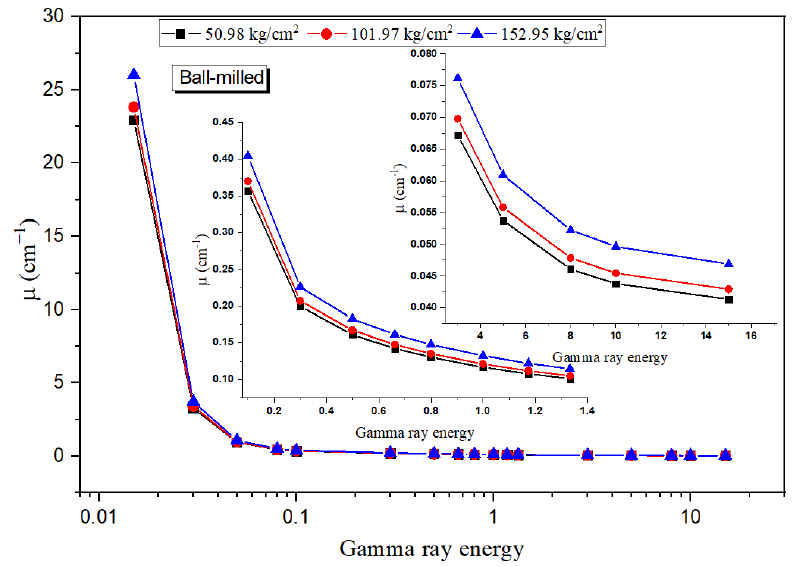
Figure 5. The linear attenuation coefficient for ball-milled bentonite at various gamma-ray energies.